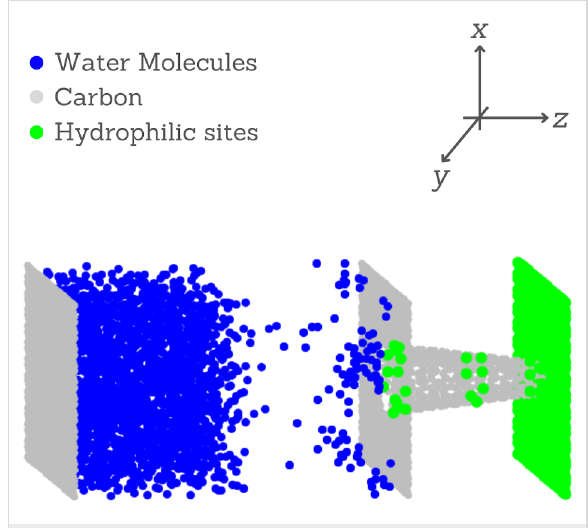
Figure 1: A snapshot of the simulation system. A liquid–vapor reser- voir in contact with a carbon slab and with the nanocone hydrophilic base. The nanocone tip is in contact with the hydrophilic slab of a collecting reservoir.